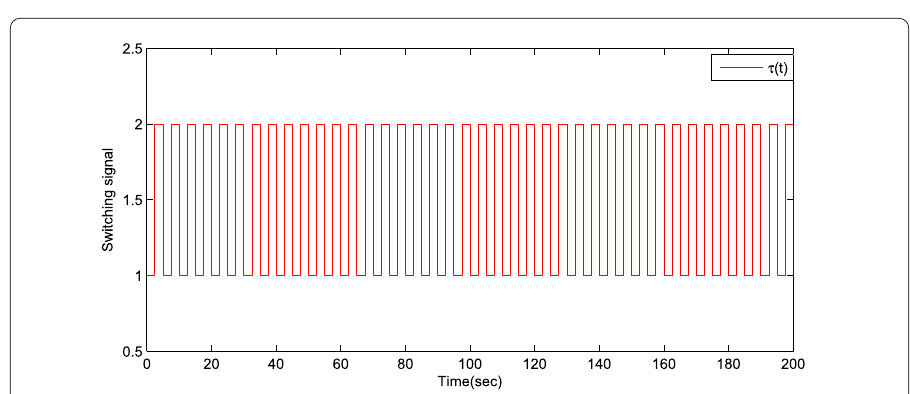
Figure 11 Responses of the control switching signal of Example